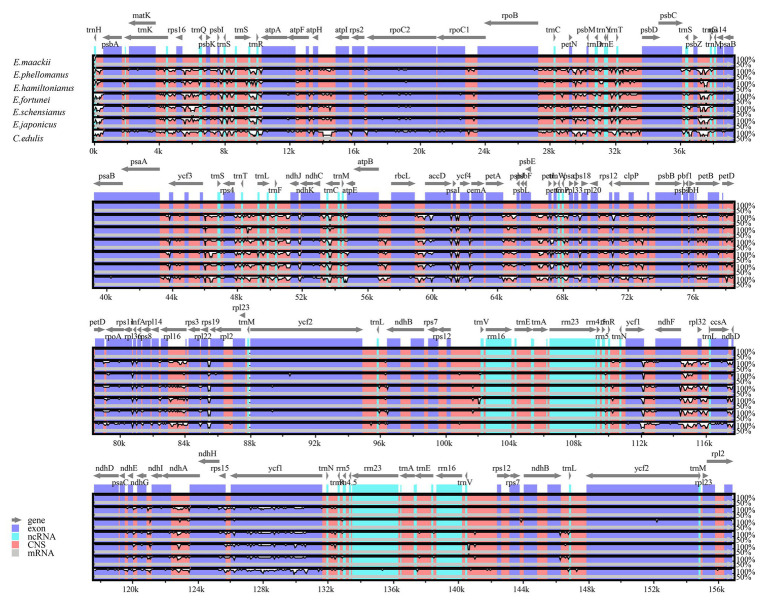
Comparison of six Euonymus cp genomes using mVISTA, with the E. phellomanus genome as the reference. The y-axis represents the percent identity within 50–100%. Gray arrows indicate the direction of gene transcription. Blue blocks indicate conserved genes, while red blocks indicate conserved noncoding sequences (CNS).